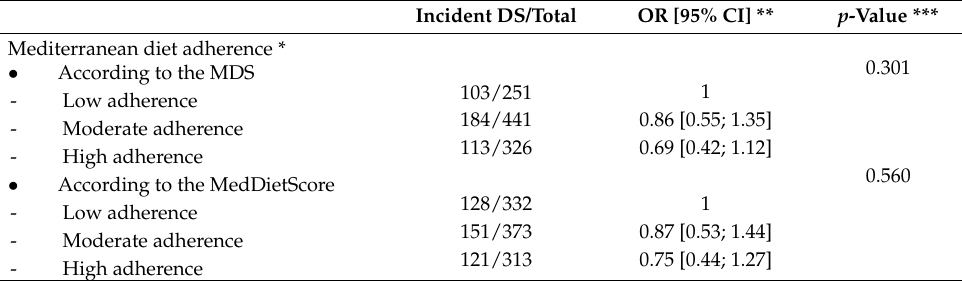
Table 5. Association between Mediterranean diet adherence and the risk of depressive symptomatol- ogy (i.e., CES-D score ≥ 16 and/or antidepressant treatment) ( N = 1018). Incident DS/Total OR [95% CI] ** p -Value